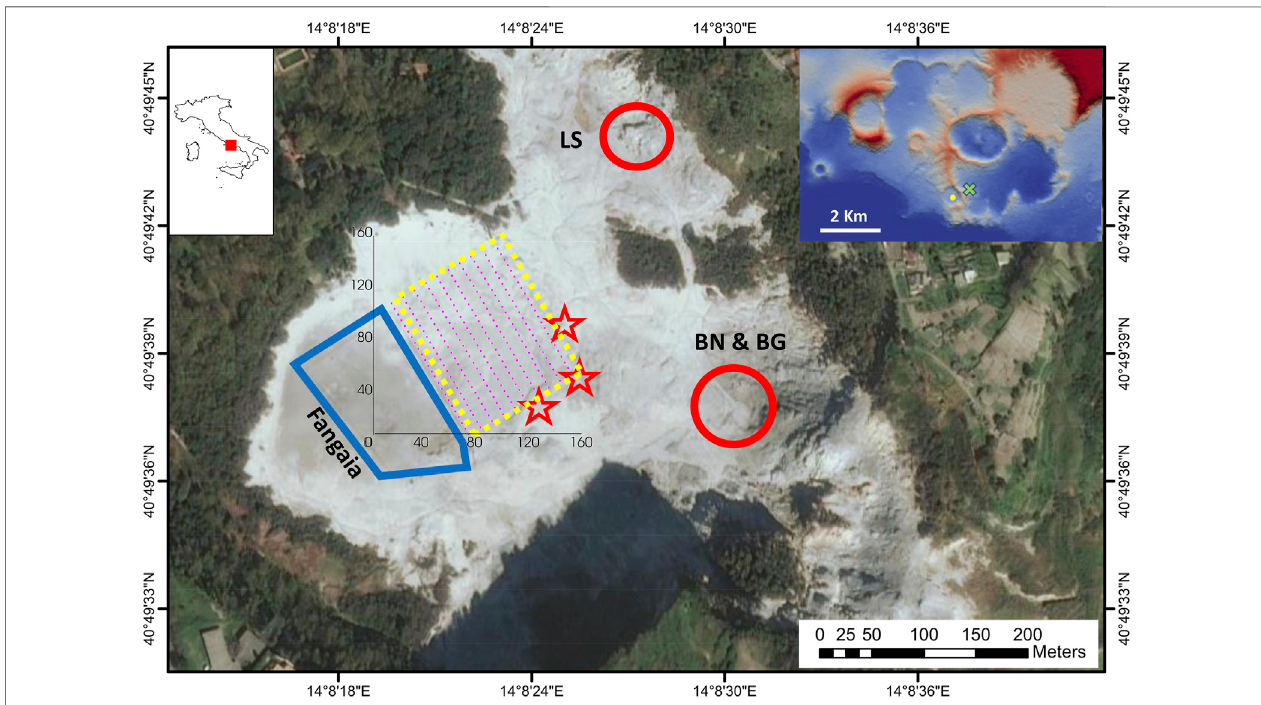
FIGURE 1 | Solfatara Crater. The topography of Campi Flegrei is shown in the upper right corner, with the survey location in yellow and the Pisciarelli fumarole indicatedbythegreencross.ThesurveyareaoftheactiveRICENexperimentisintheyellowbox,withstationlocationsinmagenta.MainHydrothermalfeatures:Fangaia (mud pool, blue contour) and fumaroles (LS: Le Stufe, BN: Bocca Nuova, and BG: Bocca Grande; in red contours). The stars indicate other fumaroles closest to the survey area (after Serra et al., 2016). The inversion grid (black axes) extends between 0 and 160 m in the SN and WE directions. See fi gure SM-1 for a close-up on the location of stations and seismic